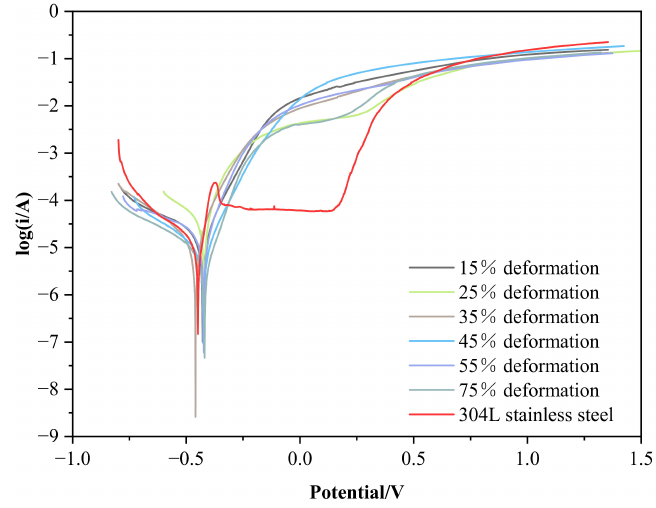
Figure 7. Polarization curves of each specimen in a 3.5% NaCl Solution.